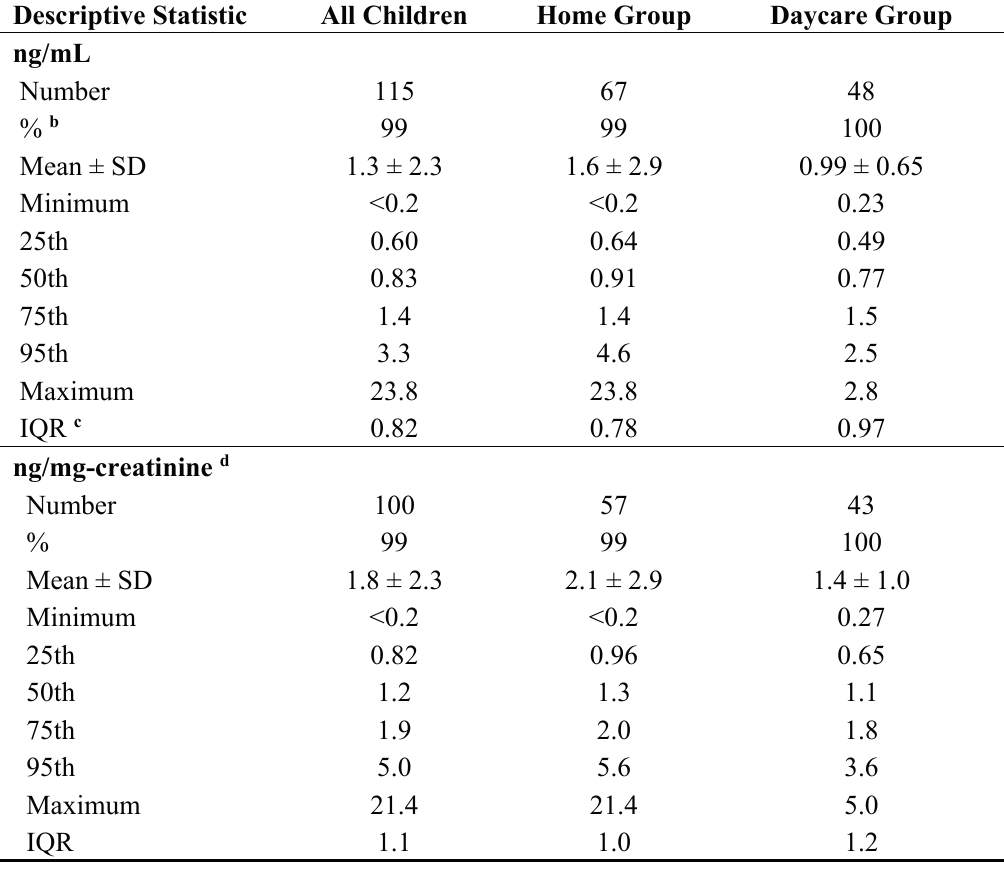
Table 1. Urinary levels of PCP in children over a 48-h monitoring period a